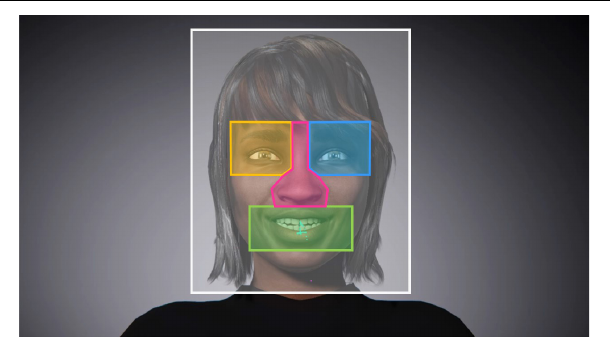
FIGURE 1 | Illustration of the areas of interest (AOI) applied on the avatars’ faces for the extraction of oculometry data. Left eye area in yellow, right eye area in blue, nose area in pink, mouth area in green, face contours area in white, and outside area in